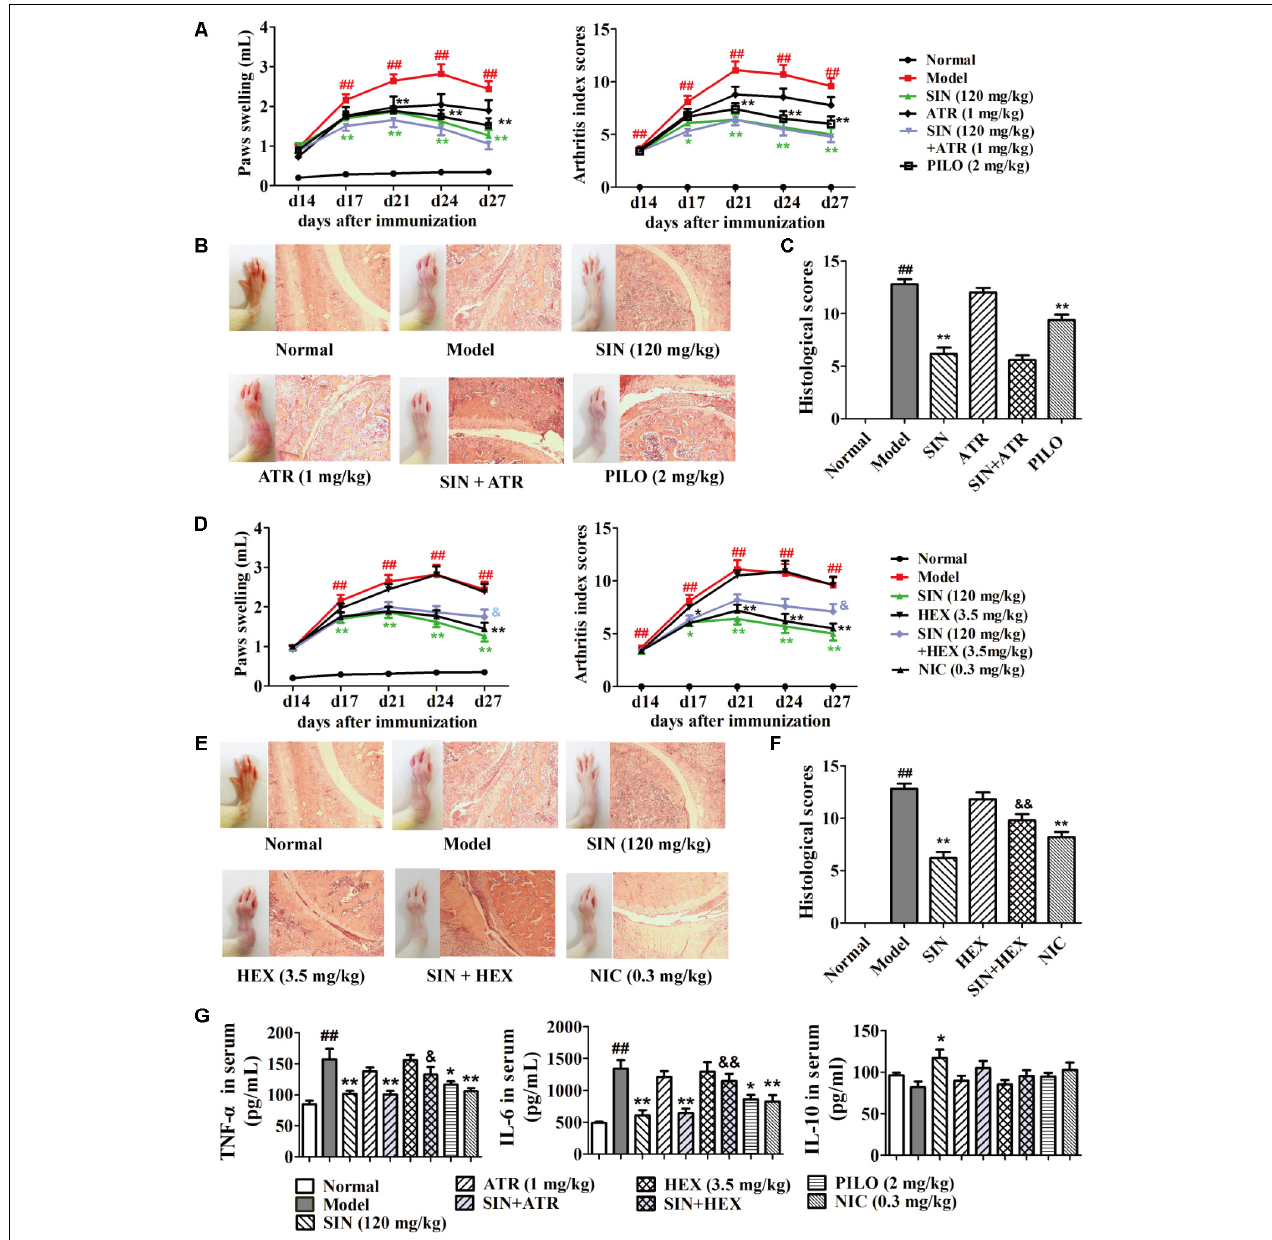
FIGURE 2 | Influence of M and N receptor antagonists on the anti-arthritic effect of sinomenine (SIN). Rats were intragastrically administered with SIN and intraperitoneally injected with ATR, pilocarpine (PILO), hexamethonium (HEX) or nicotine (NIC) from day 14 to day 28. (All data in this figure are from the same group of animal.) ATR or HEX was given 30 min before the administration of vehicle or SIN. (A,D) The paw swelling and arthritis index were determined. (B,E) Photographs of representative hind paws were taken, and histopathological changes of right ankle joints in each group were determined by HE staining (original magnification 200 × ). (C,F) The histological scores of each group were calculated. (G) The serum levels of TNF- α , IL-6, and IL-10 were measured by ELISA. Data were expressed as means ± SEM, n = 6–8. F -values were 3.92 for paw swelling and 6.59 for arthritis index in (A) , and F -values were 11.98 for paw swelling and 9.25 for arthritis index in (D) . # P < 0.05 and ## P < 0.01 versus Normal; ∗ P < 0.05 and ∗∗ P < 0.01 versus Model; & P < 0.05 and && P < 0.01 versus